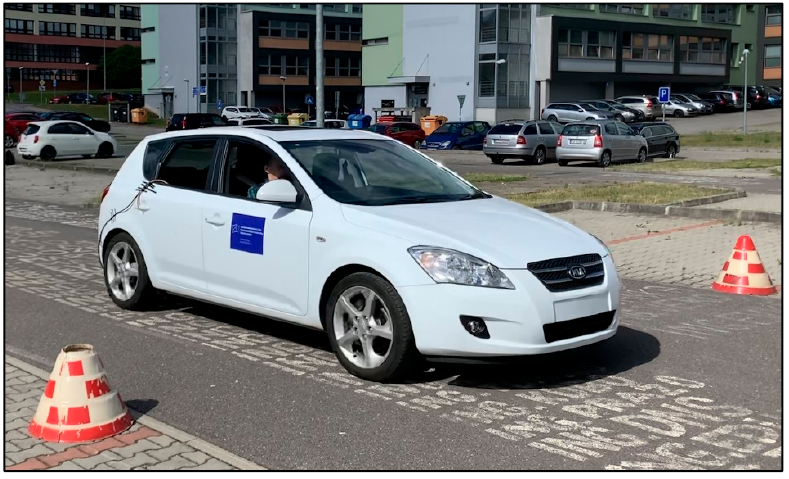
Figure 1. Measuring vehicle [author].